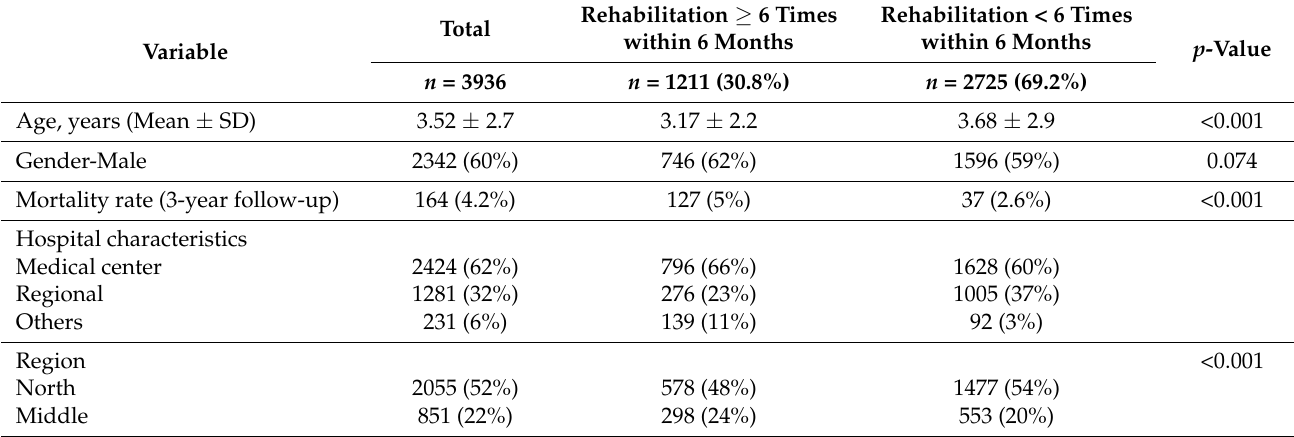
Figure 1. Population flowchart. Patients with moderate to severe cerebral palsy diagnoses were enrolled from the NHIRD dataset. Patients were divided into two groups according to rehabilitation frequency. Abbreviation: NHIRD: National Health Insurance Research Database; CP: cerebral palsy. Table 1. Baseline characteristics of severe CP children, n =